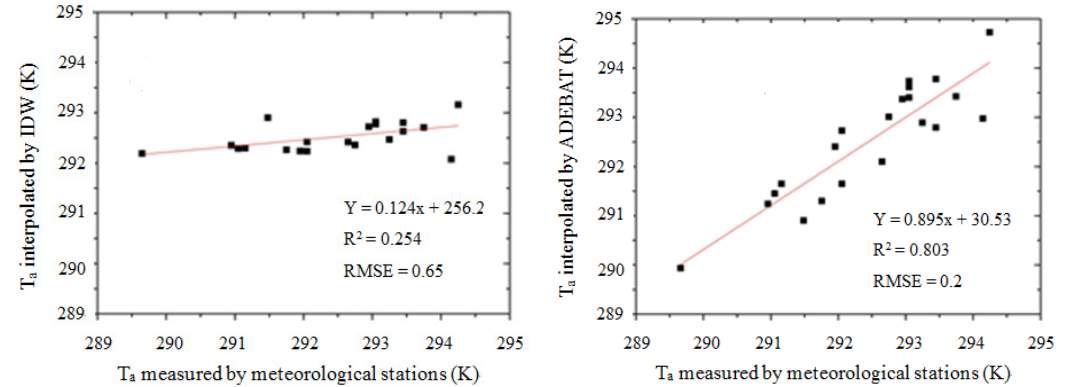
Figure 2. Comparisons between T a measurements and T a estimates from the inverse distance weighted (IDW) method ( left ) and the advection-energy balance for air temperature (ADEBAT) method ( right ) on 8 April, 30 August and 17 October in